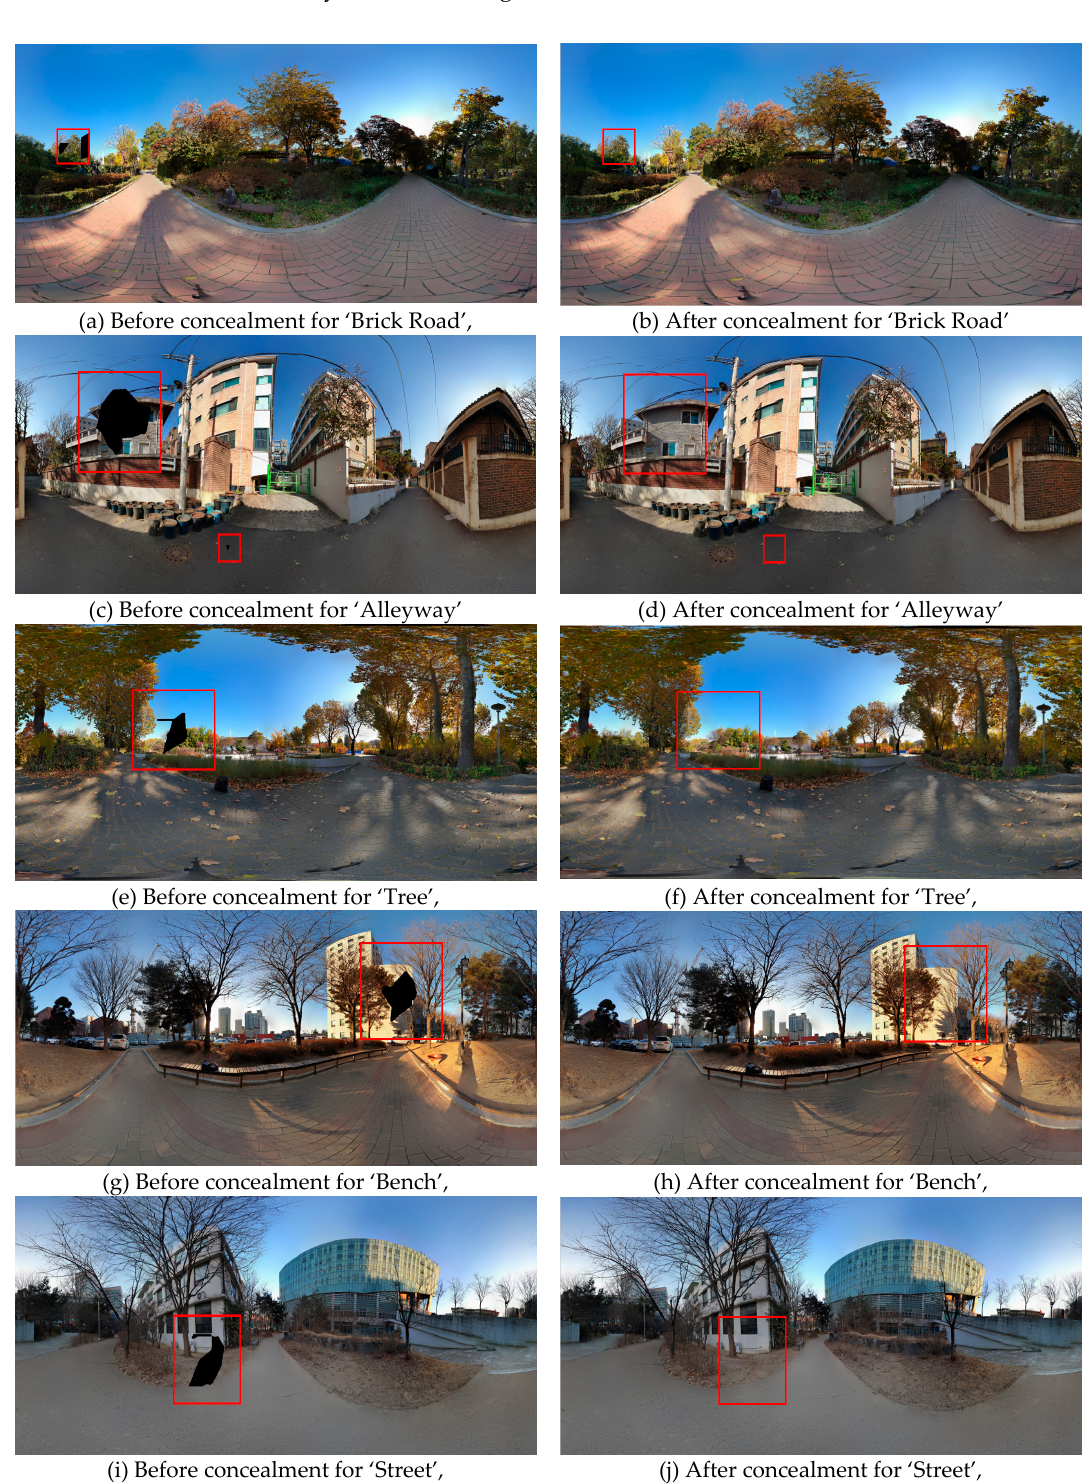
Figure 9. ERP images including holes and the concealed regions, where the holes are concealed by the proposed algorithm.